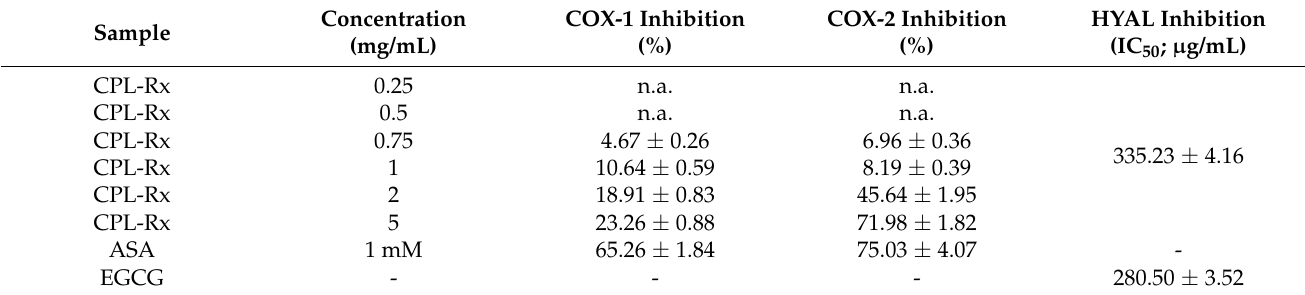
Table 3. Inhibition of COX-1, COX-2, and hyaluronidase (Hyal) activity in the presence of R. rugosa root crude polysaccharide